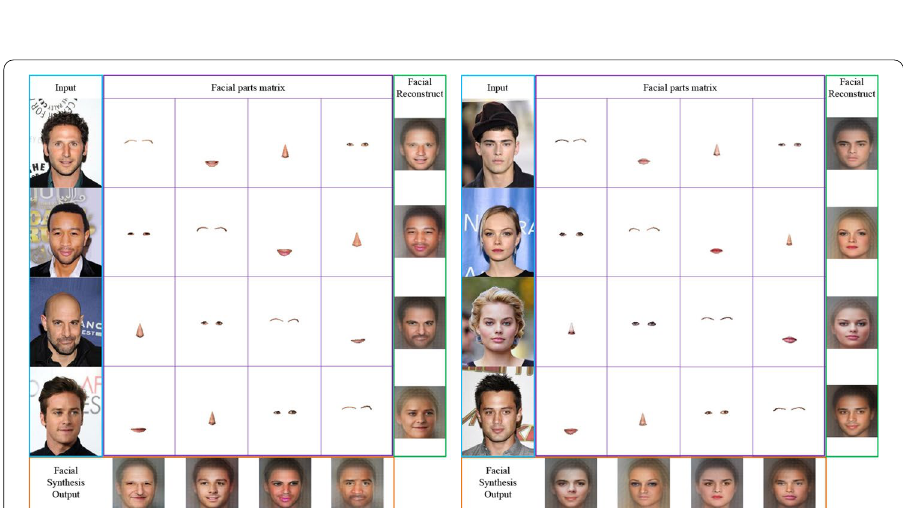
Random face synthesis from facial parts. Two facial parts combined matrices are shown here. In each matrix, the first column is the input image, each row is a decomposition of the input face, the last column is the reconstruction of the input, and the last row is the portrait synthesis